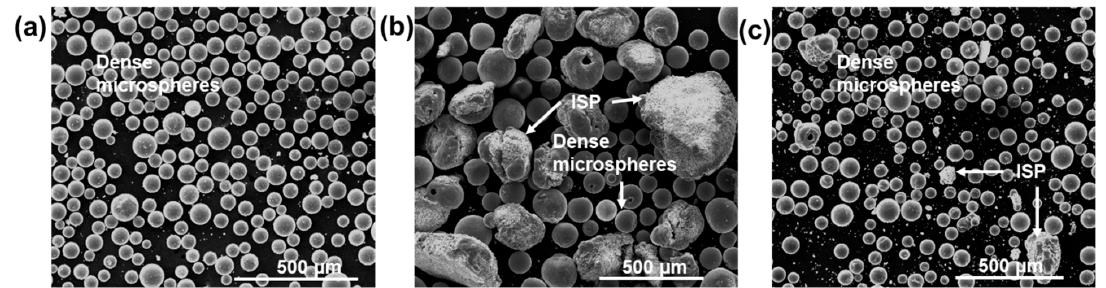
Figure 1. SE images of flame-spheroidised Fe 3 O 4 :CaCO 3 , using starting ≤ 5 µ m sized Fe 3 O 4 powders. Mass ratios: ( a ) 3:1, ( b ) 1:1 and ( c ) 1:3, (unsieved), showing dense microspheres and irregular-shaped particles. ISP: irregular-shaped particles.